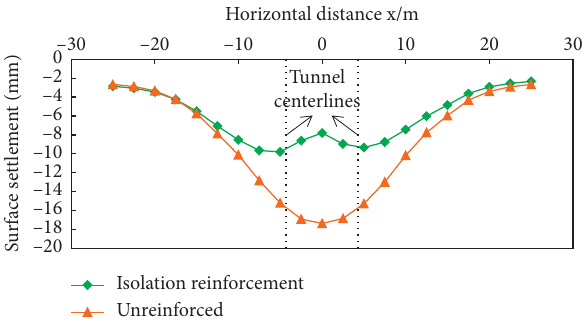
Figure 11: Transverse subsidence curve of the surface before and after reinforcement.